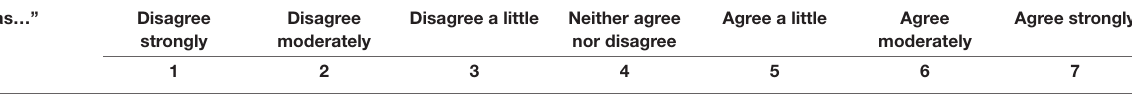
TABLE 2 | Ten-Item Personality Inventory (adapted from Gosling et al., 2003, p. 525). “I see myself